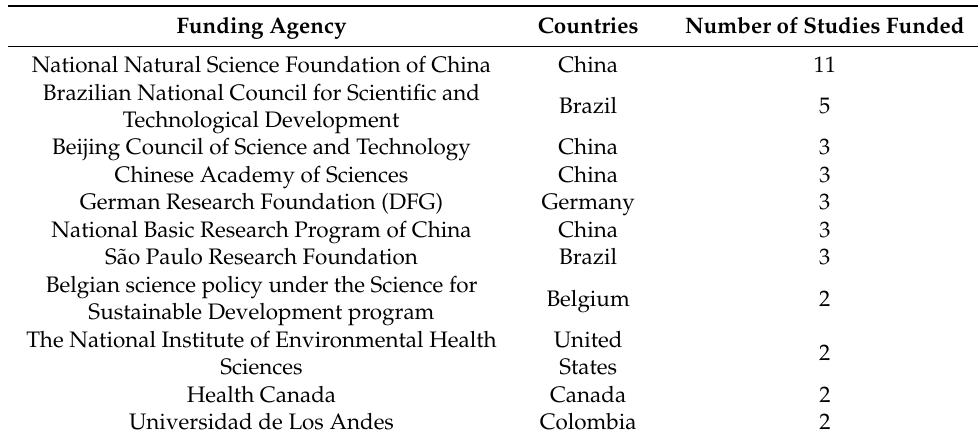
Table 3. The main funding agencies of studies.